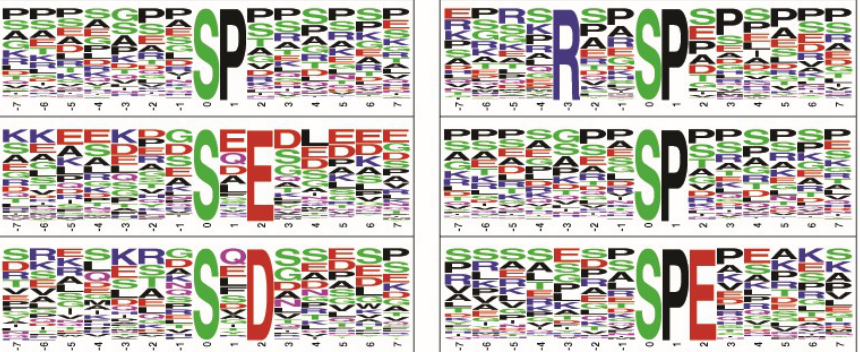
Figure 3. Motif analysis of hyperphosphorylated and hypophosphorylated proteins in RB. Motif analysis identified a proline-directed phosphorylation motif, aspartate and glutamate (acidic aminoacid) directed phosphorylation motifs to be enriched in hyperphosphorylated proteins.